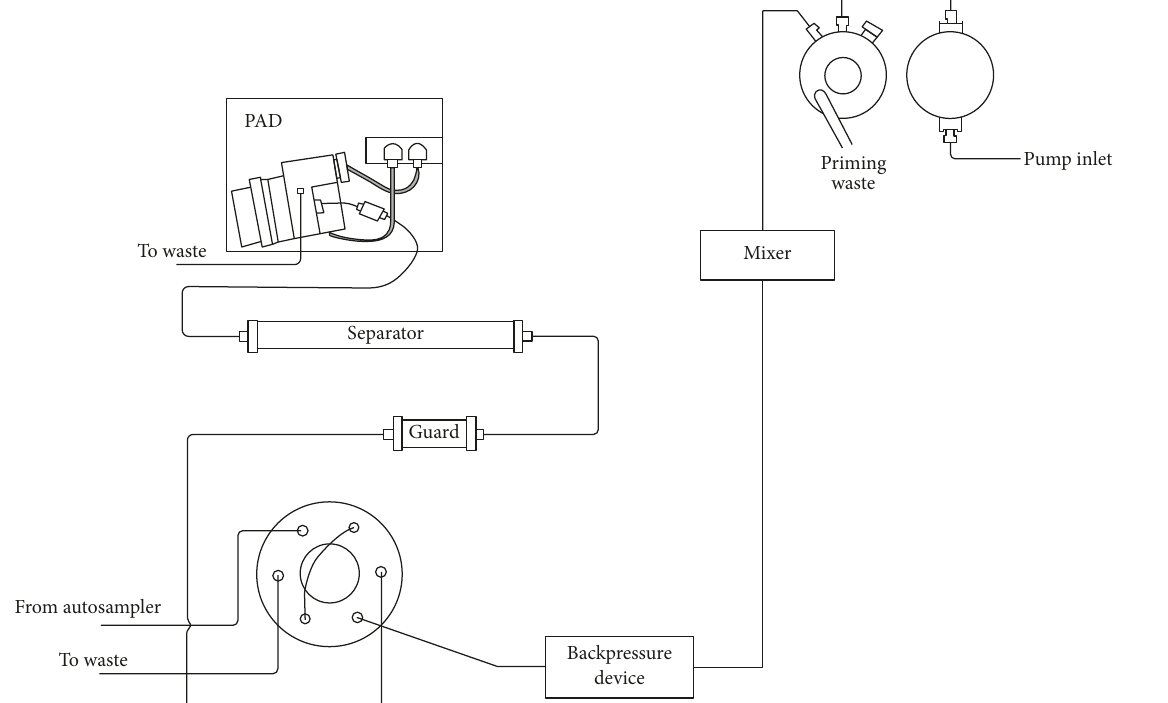
Figure 1: Schematic diagram of the instrumental